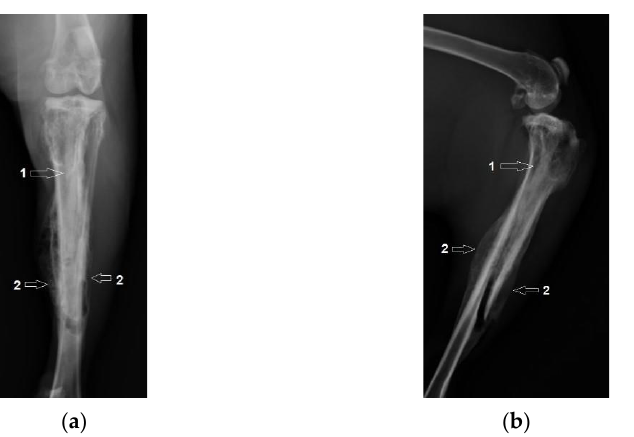
Figure 8. Tibial fracture, 6 weeks after surgery. 1-The Mg-1Ca alloy implant, 2-Fracture line in the tibial diaphysis. ( a ) Coronal view; ( b ) Lateral view.